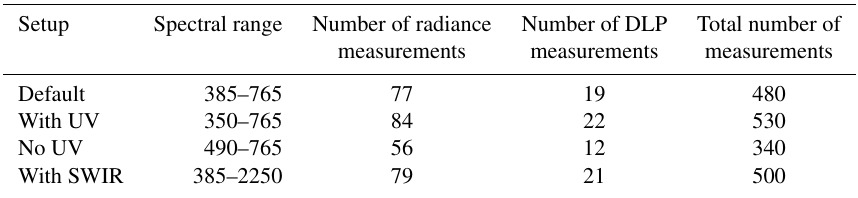
Figure 3. (cid:104) (cid:49) XCO 2 (cid:105) as a function of total aerosol optical depth at 765nm for all 60 study scenarios. The two lines in each panel show (cid:104) (cid:49) XCO (cid:105) for two different (cid:49)I/I values, as computed for the MAP-mod concept with five viewing angles, where (cid:49) DLP = 0 . 003 is assumed. 2 The MAP-mod spectrum for each scenario extends from 385 to 765nm. Table 6. List of the four options for the MAP-mod spectral